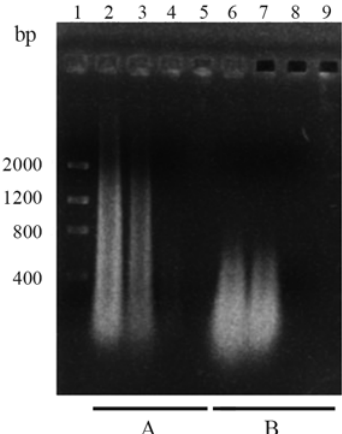
Figure 1 - Electrophoresis results of three different sloth skin DNA sam- ples obtained with prior hydration (A = lanes 2, 3 and 4) and without prior hydration (B = lanes 6, 7 and 8). Lane 1 = low mass DNA molecular marker.Lanes5and9=blank.SomeDNAsamplesobtainedusingthehy- drating step show an increase in higher molecular size fragments. Lane 4 shows only a small amount of DNA and in lane 8 the DNA concentration is so low that it cannot be seen in the gel. All lanes were loaded with 4 μ L of DNA